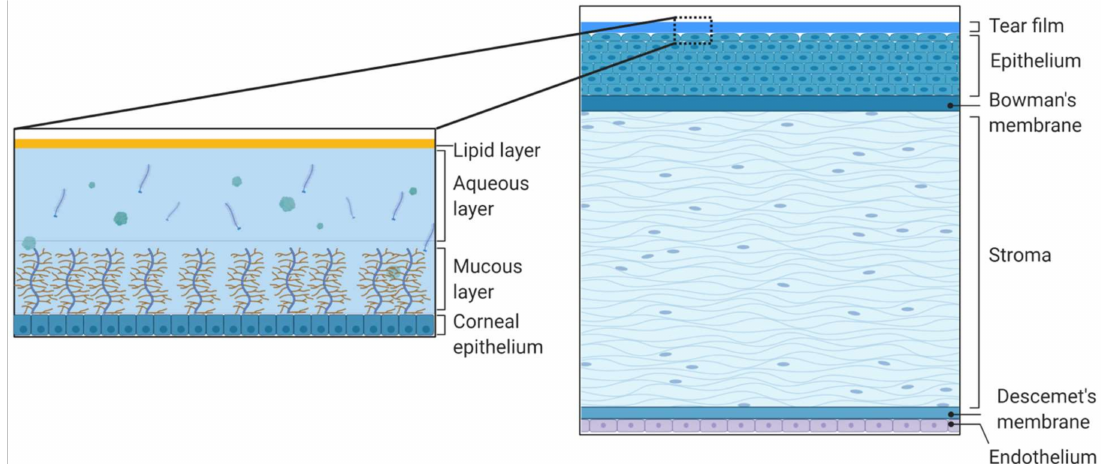
Figure 2. Schematic representation of the structure and composition of the cornea and the tear film. The cornea consists of the tear film, epithelium, Bowman’s membrane, stroma, Descemet’s membrane, and inner endothelium. The tear film consists of the outer lipid phase, intermediate aqueous phase, and mucus. Created with